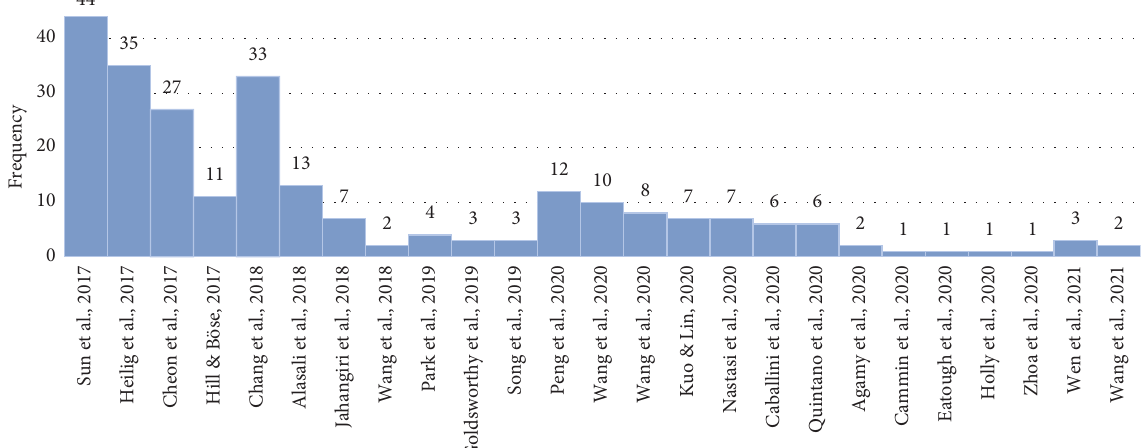
Figure 4: Citations of the selected articles (the last update was on 15 th October,